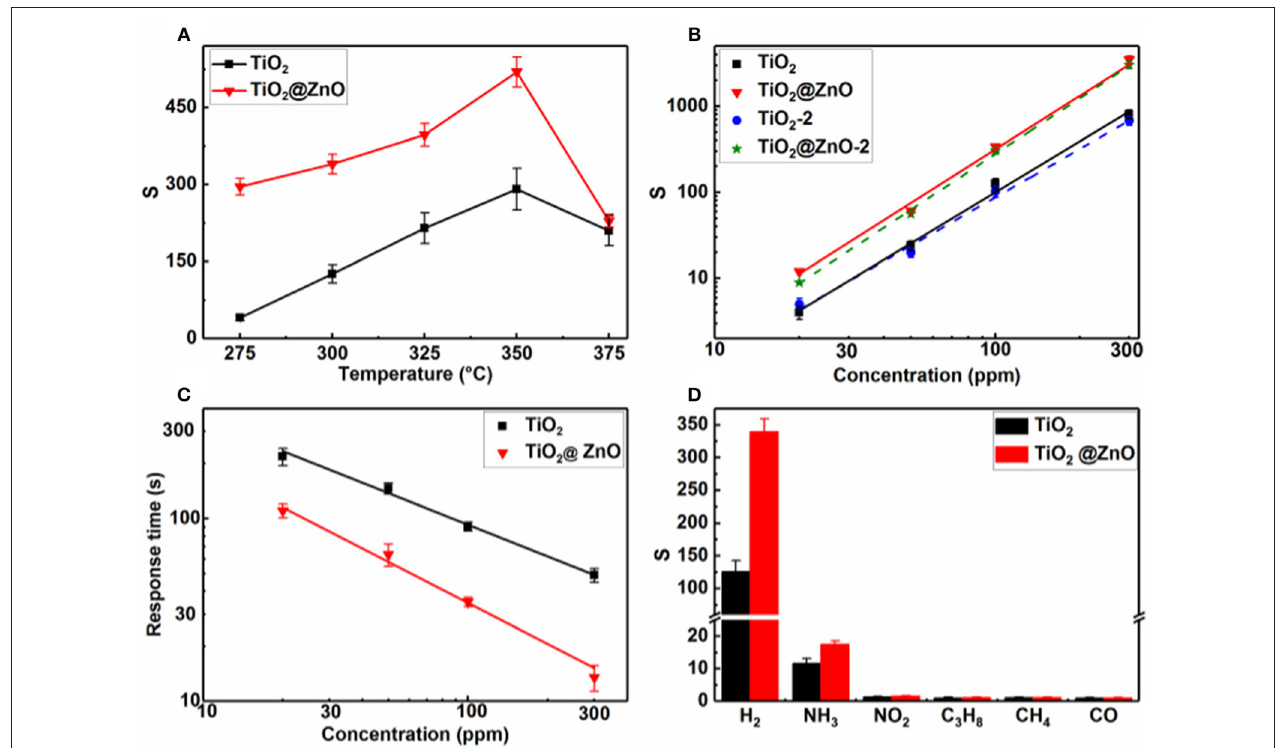
FIGURE 5 | Response of pristine TiO 2 and TiO 2 @ZnO composite sensors as a function of (A) temperature to 100-ppm H 2 and (B) H 2 concentration at 300 ◦ C; (C) response time of pristine TiO 2 and TiO 2 @ZnO composite sensors vs. H 2 concentration at 300 ◦ C; (D) response of pristine TiO 2 and TiO 2 @ZnO composite sensors to 100-ppm various gases at 300 ◦